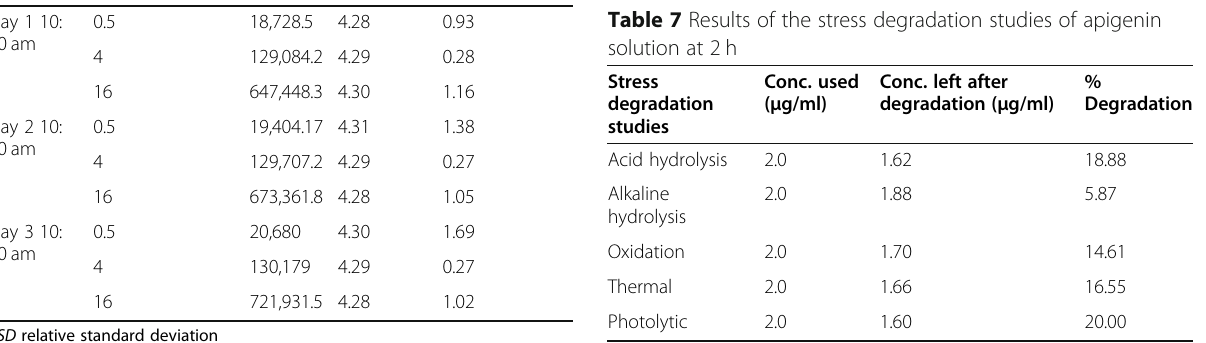
Table 5 Results of interday precision data of apigenin samples Day / time